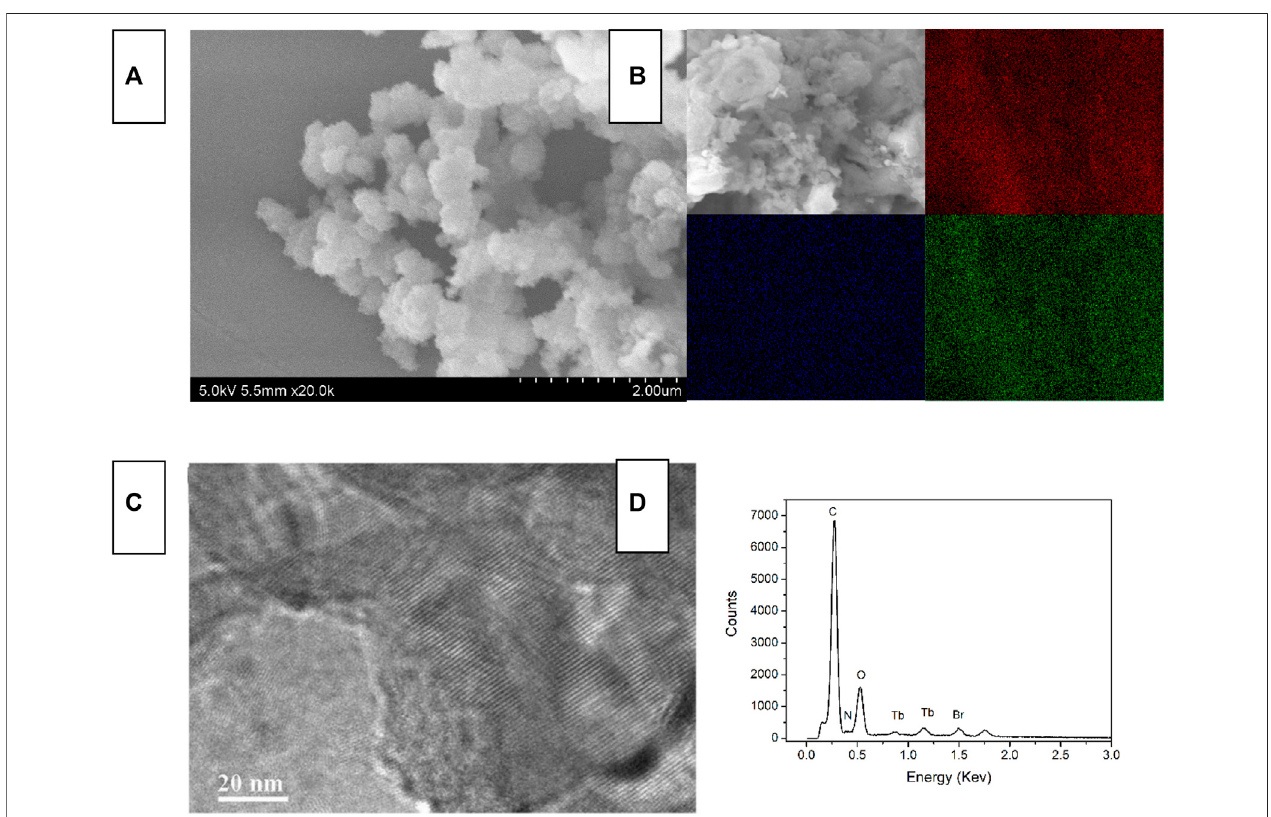
FIGURE 4 | SEM image (A) , elemental mapping [ (B) , red = C, blue = N, and green = Tb], TEM (C) and EDX (D) of Tb-COF.